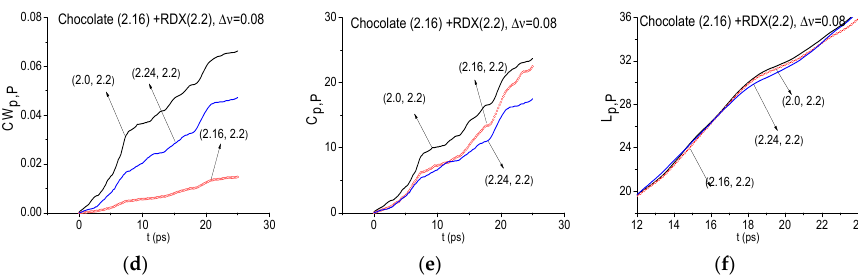
Figure 11. ICC’s CW p,P ( a ), C p,P ( b ) and L p,P ( c ), calculated at the frequency ν = 2.2 THz for signal Chocolate and the standard RDX_Air signal with the spectral resolution Δ ν = 0.01, 0.04 THz ( a – c ), 0.08 THz ( d – f ).